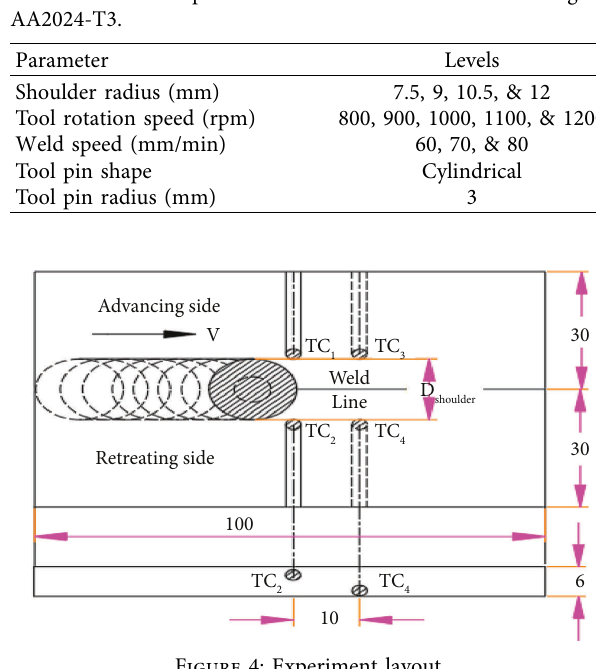
Table 2: Levels of process variables for friction stir welding on